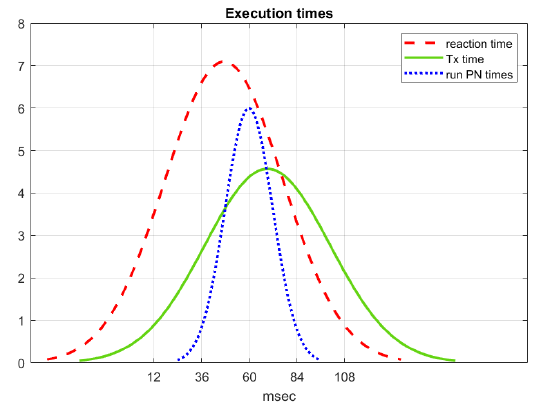
Figure 21. Reaction times of the executive